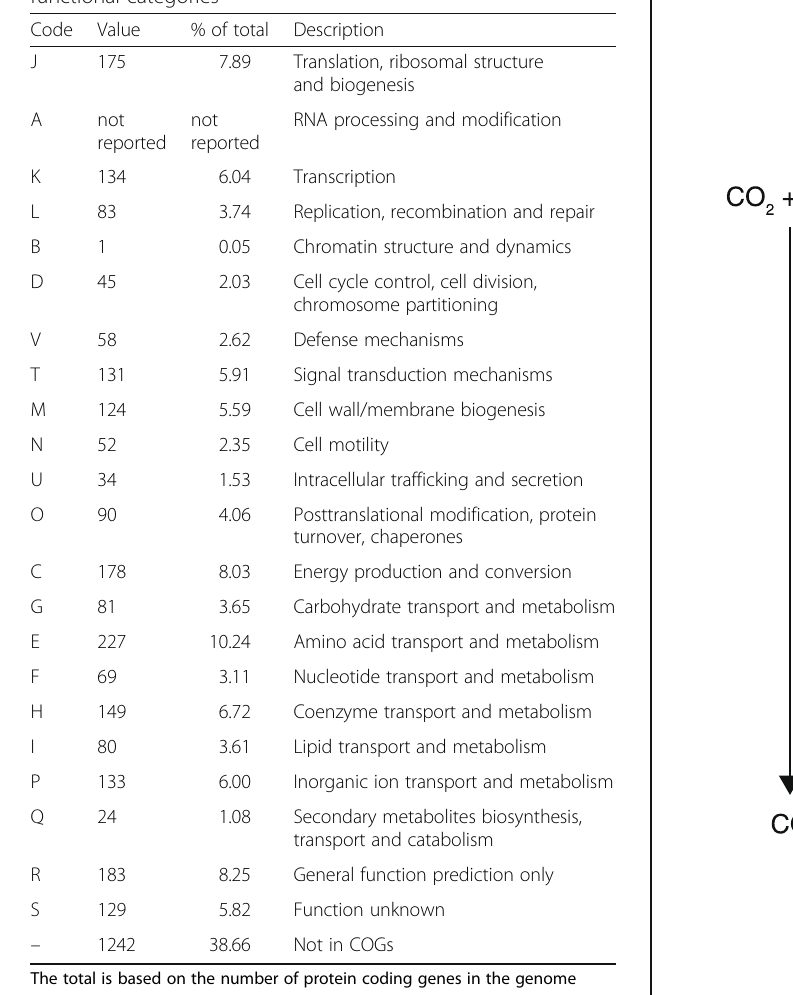
Table 4 Number of genes associated with general COG functional categories